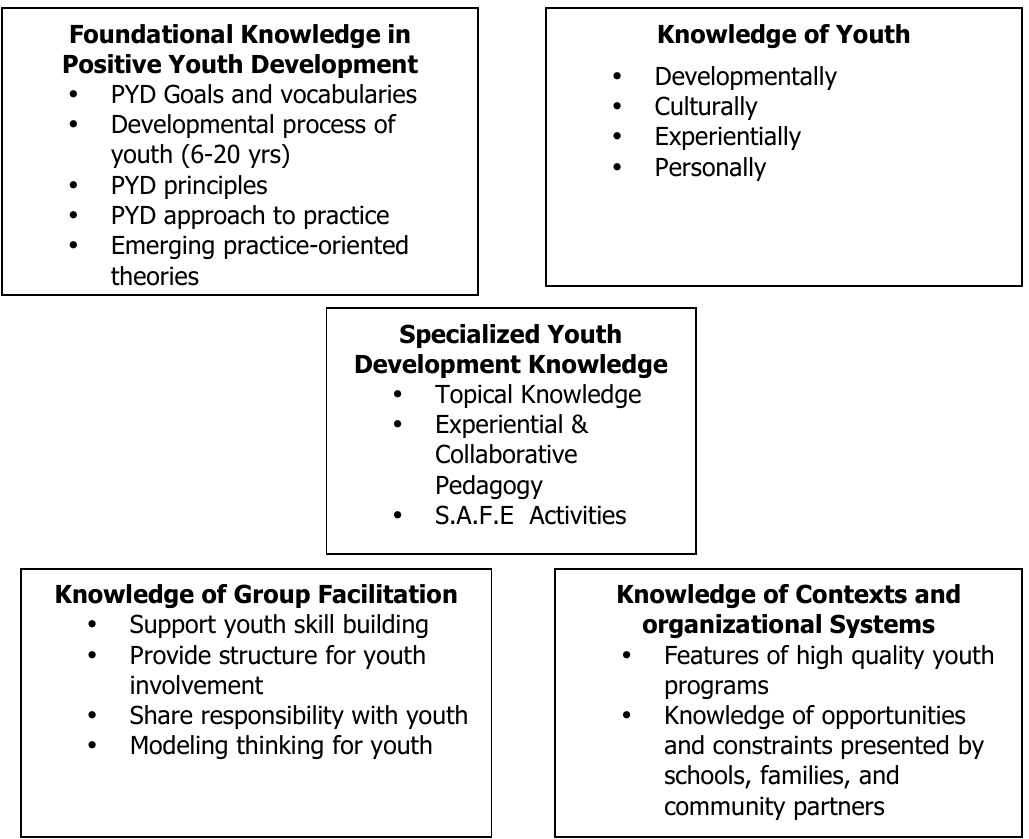
Model of Knowledge for Youth Development